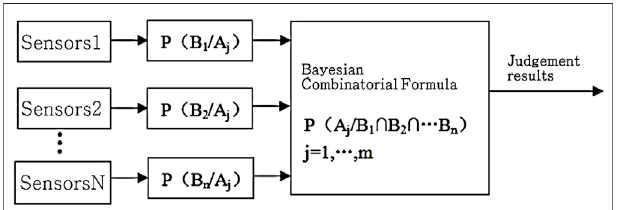
FIGURE 2 | Bayesian data convergence process.